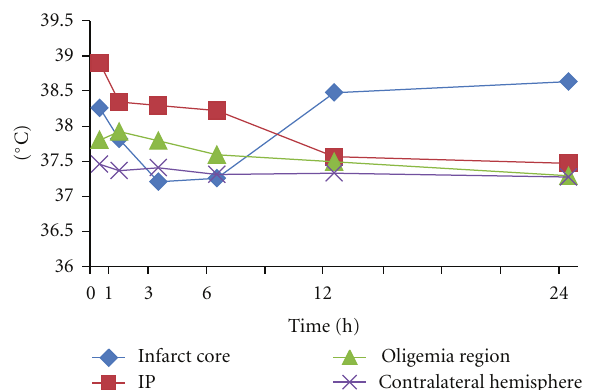
Figure 2: Evolution of the brain temperature of di ff erent ischemic regions and the contralateral hemisphere at the artery occlusion stage (0h) and reperfusion stage in the monkey MCAO